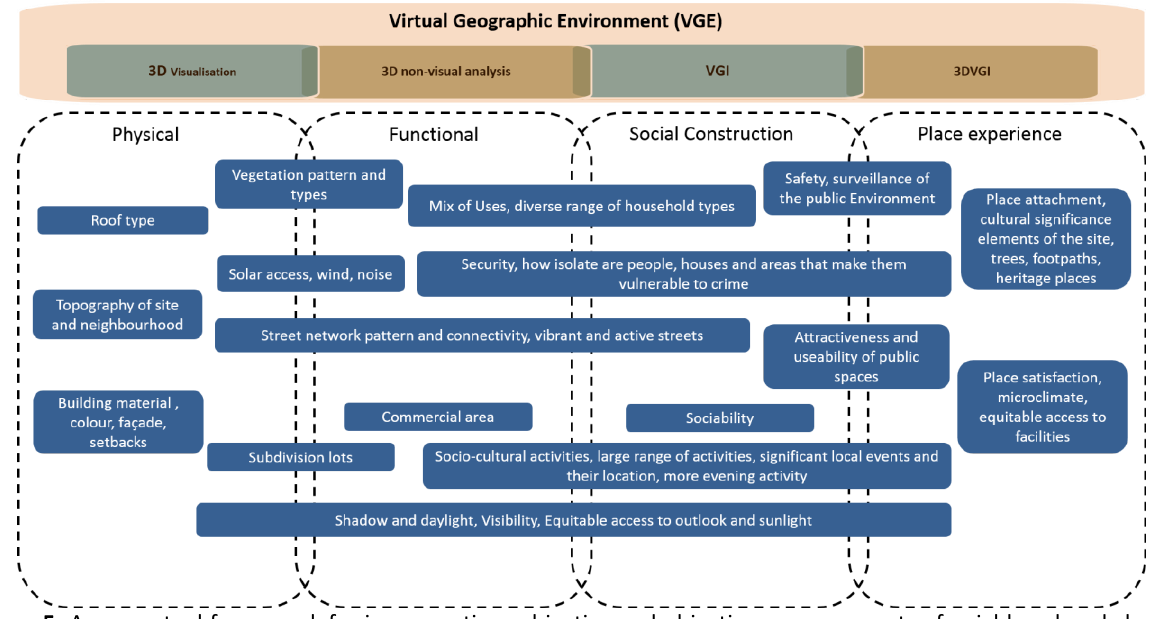
Figure 5. A conceptual framework for incorporating subjective and objective measurements of neighbourhood charac- ter in a Virtual Geographic